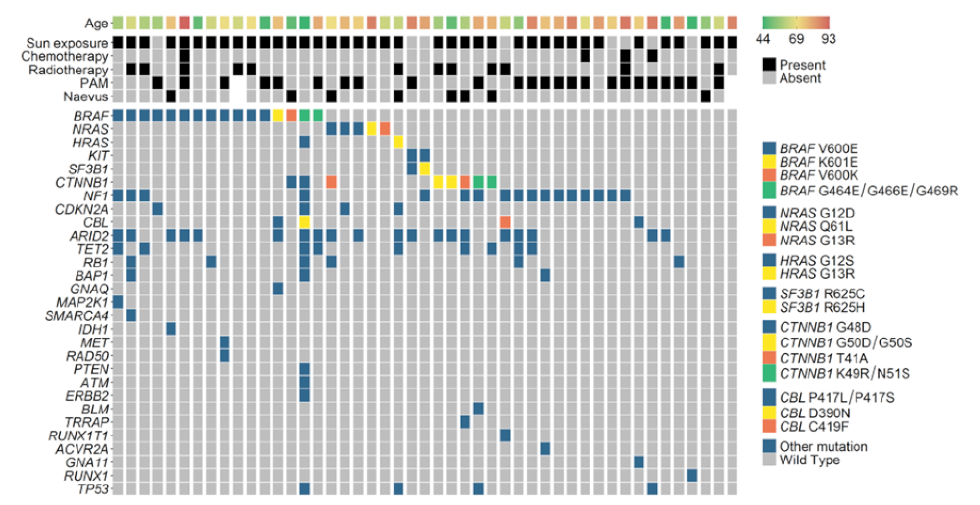
Figure 2. OncoPrint of mutations in melanoma-associated genes. PAM: primary-acquired melanocytosis.